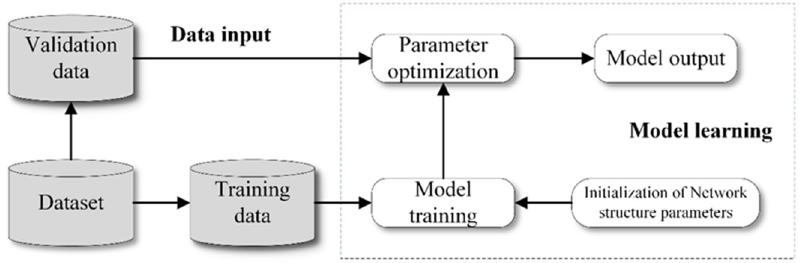
Figure 1. The flowchart of deep learning.